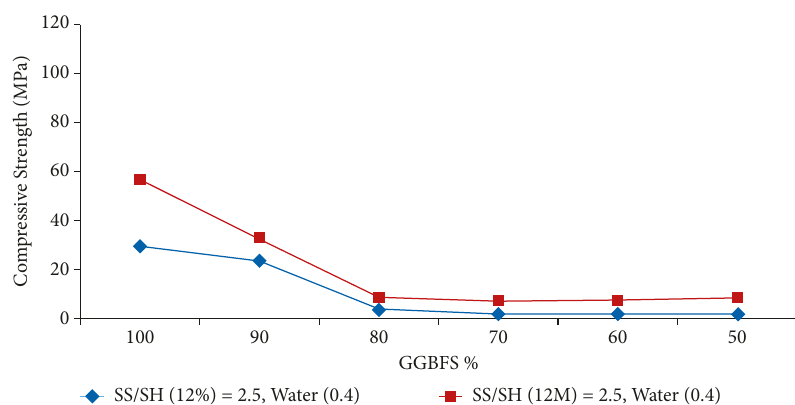
Figure 3: The impact of NaOH molar proportion on the compressive strengths at 7 curing days.